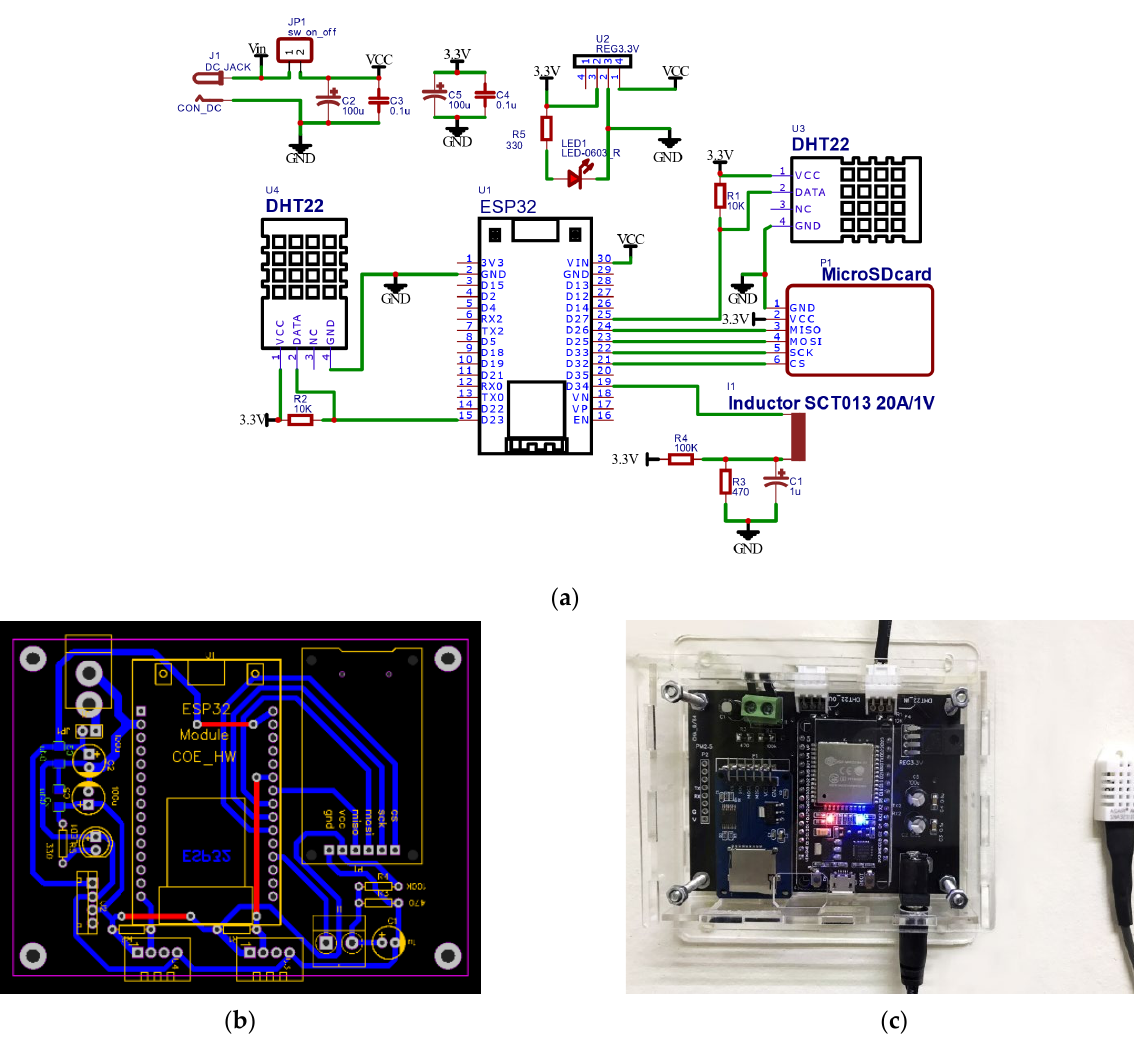
Figure 2. Schematic of the data acquisition setup as designed for this work : ( a ) diagram of electronic components and mechanical connectivity of device; ( b ) a printed circuit board ( PCB ) for the device electrical current flow; ( c ) prototype of sensor related devices .